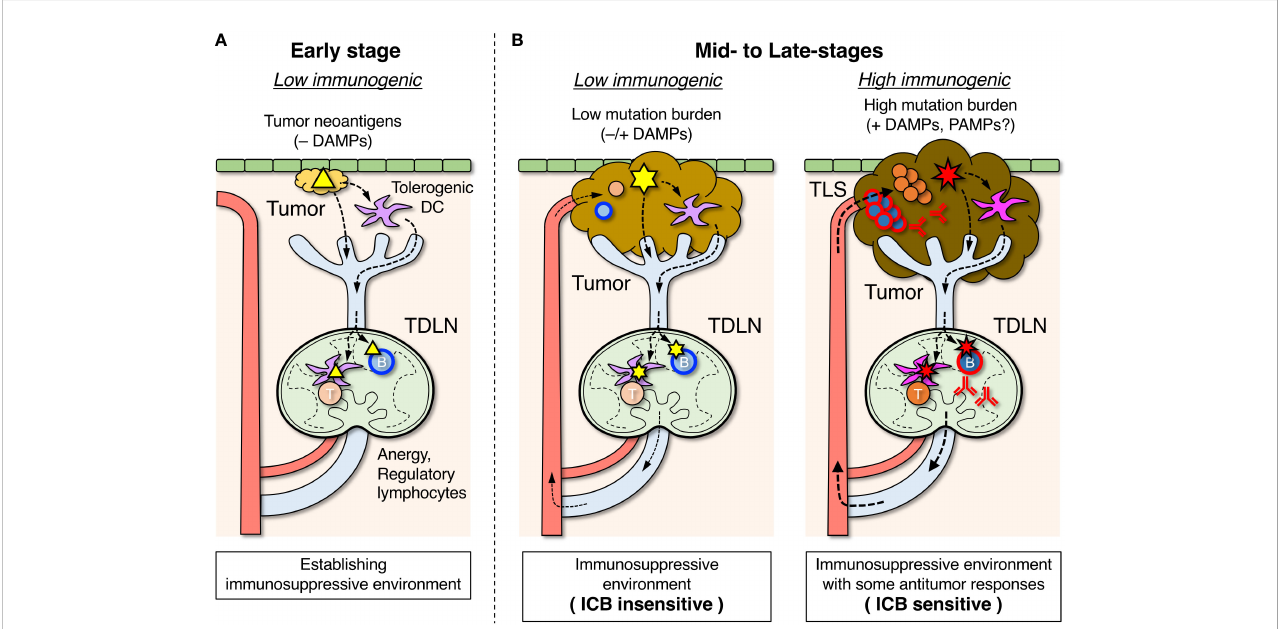
FIGURE 2 Roles of tumor-draining lymph nodes (TDLNs) in the suppression and activation of antitumor immune responses. (A) In the early stage, tumor antigens ( △ ) are transported to TDLNs by DCs that have become tolerogenic in the absence of damage-associated molecular pattern (DAMP) stimuli and induce lymphocyte anergy and regulatory subsets which create an immunosuppressive environment. Some B cells differentiate into Breg cells, which are involved in suppressing the antitumor response. (B) In mid- to late-stages of tumor development, an immunosuppressive environment is already formed in TDLNs. When tumor mutation burden and DAMP stimuli are relatively low, emerging tumor antigens ( ) derived from new mutations are transported by tolerogenic DCs, and unresponsiveness of lymphocytes in TDLNs is maintained (left). When tumor mutation burden and DAMP stimuli due to immunogenic cell death are relatively high, the highly mutated tumor antigens ( ) transported by immunogenic DCs can activate the antigen-speci fi c lymphocytes in TDLNs to some degree (right), and a fraction of activated lymphocytes migrates to in fi ltrate the tumor or form tertiary lymphoid structures (TLSs). The ef fi cacy of immune checkpoint blockade (ICB) therapy depends on the extent of the ongoing antitumor